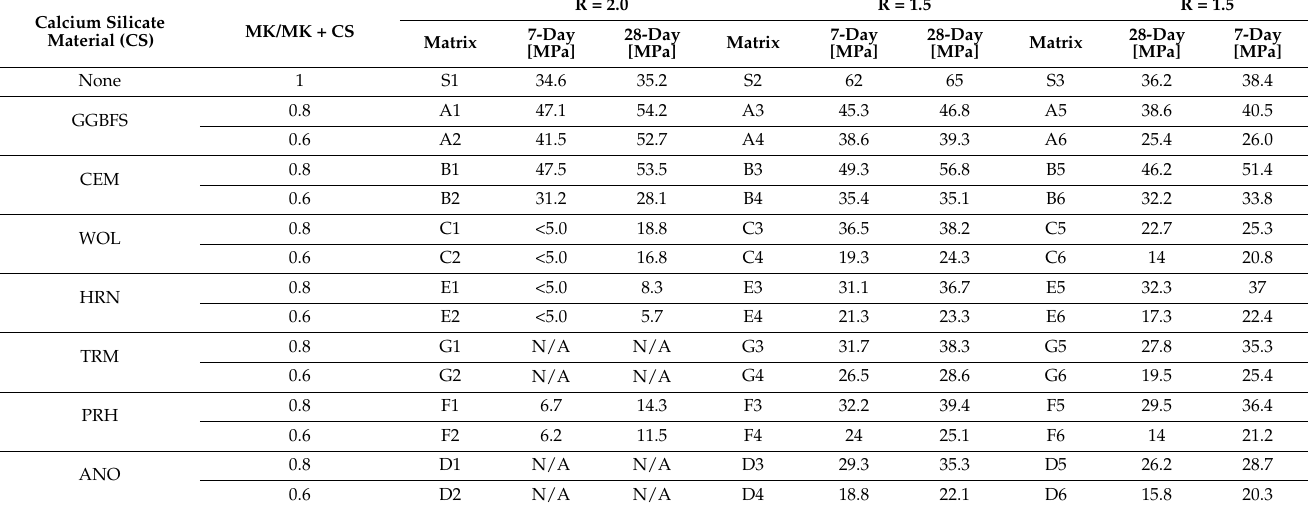
Table 7. Compressive strength with different amounts of calcium and alkaline solution